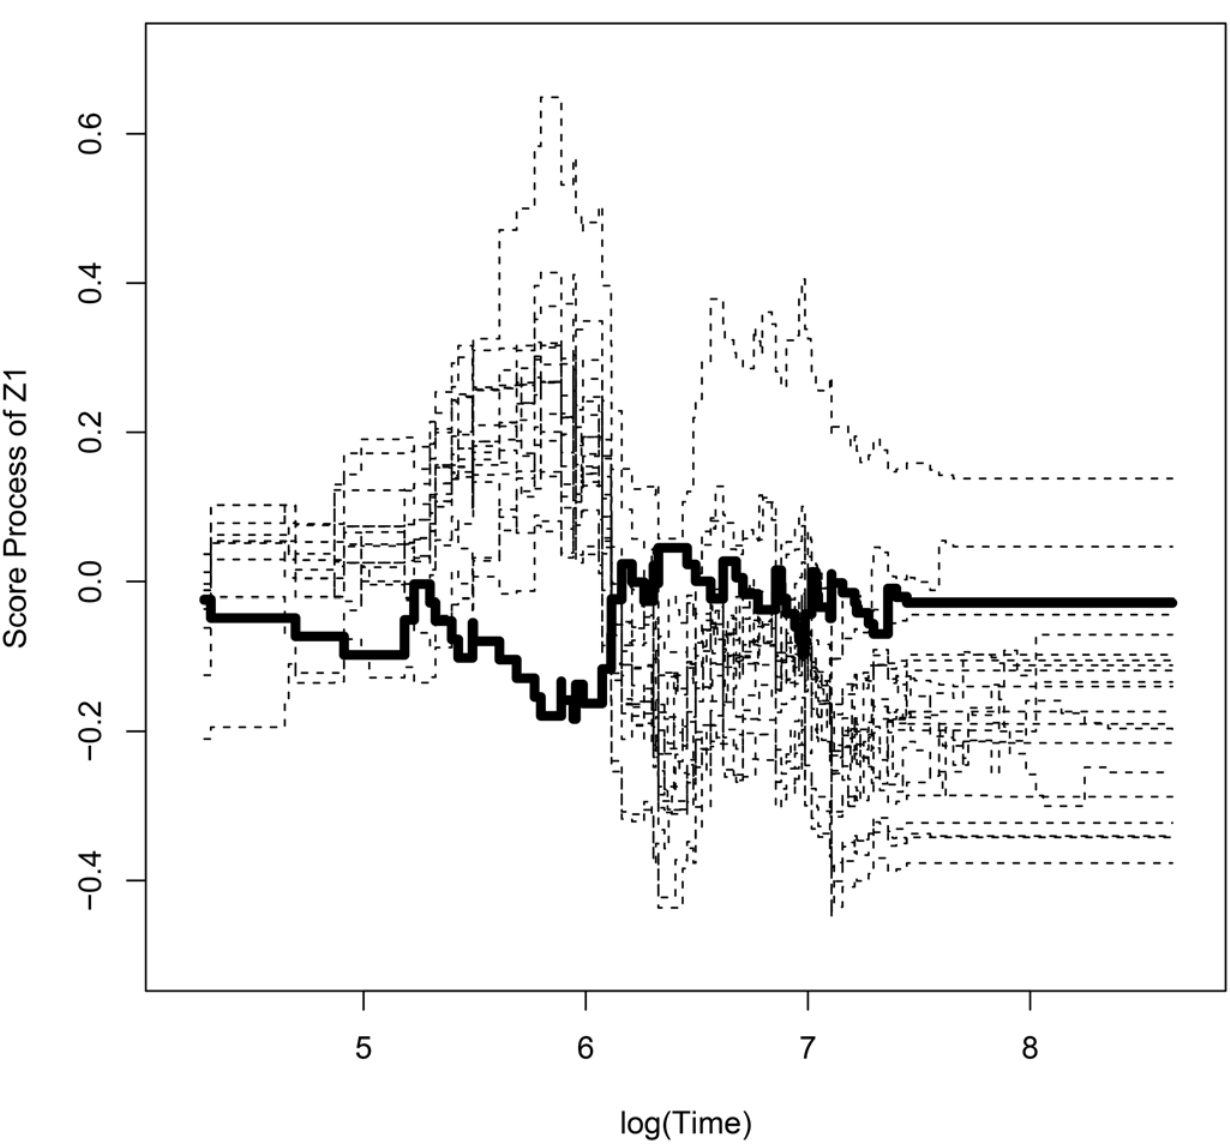
Fig 2. Plot of observed score process and bootstrapped processes of time to first virologic failure using ^ α L with respect to Z 1 . The thickline is observed process and the dashed lines are bootstrapped processes .